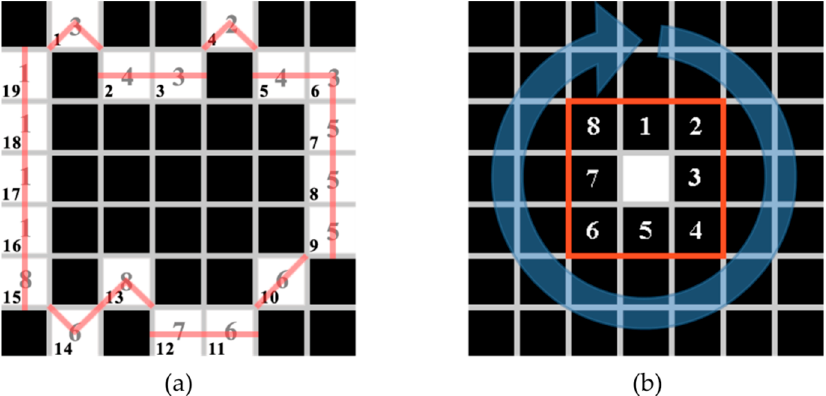
Figure 14. Shape perimeter determination: ( a ) Shape with the marked optimal perimeter path; ( b ) Way of searching neighbor pixels on borders of a shape.